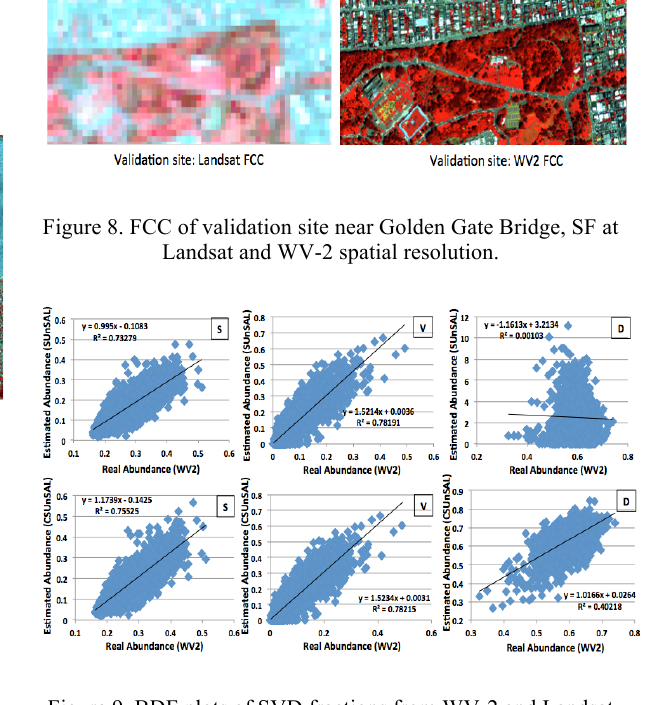
Figure 9. BDF plots of SVD fractions from WV-2 and Landsat and regression lines of WV-2 estimates (real abundance) versus estimated abundance from SUnSAL and